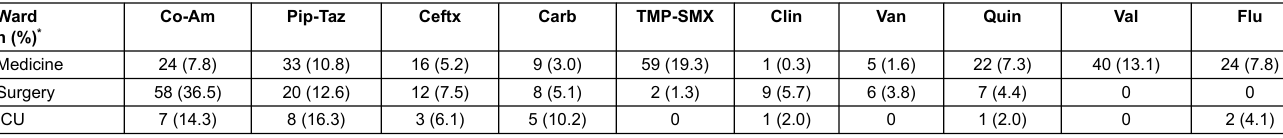
Table 2: Distribution of the 10 most frequently used antimicrobial prescriptions (n = 411 out of 548) according to the ward. Ward n (%)